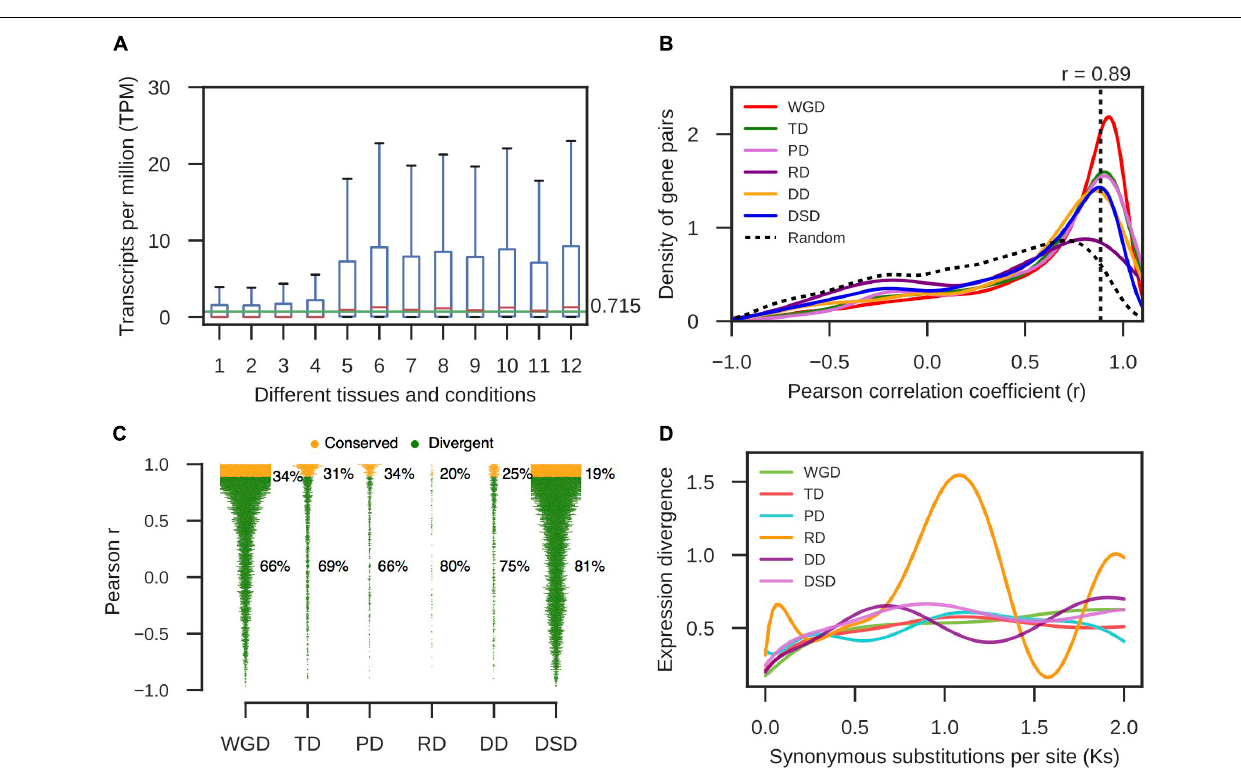
FIGURE 4 | The expression divergence between duplicate genes in pear. (A) The distributions of TPM values in different tissues and conditions for intergenic sequences. The horizontal green line indicates the mean value of the medians in different boxplots. (B) The density distributions of Pearson’s correlation coefficient ( r ) between the expression profiles of two copies of different modes of duplicated pairs. The vertical dotted line indicates the 95% quantile in the r -values distribution for 10,000 random gene pairs. (C) The proportion of divergent and undifferentiated (or conserved) gene pairs in expression. (D) The dynamic expression divergence between duplicate genes with increasing K s